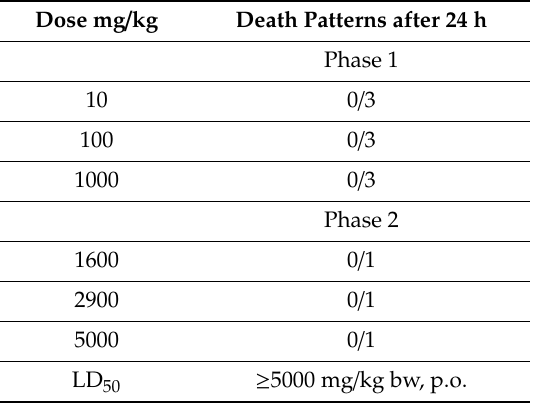
Table 2. Acute toxicity study of T. o ffi cinale in